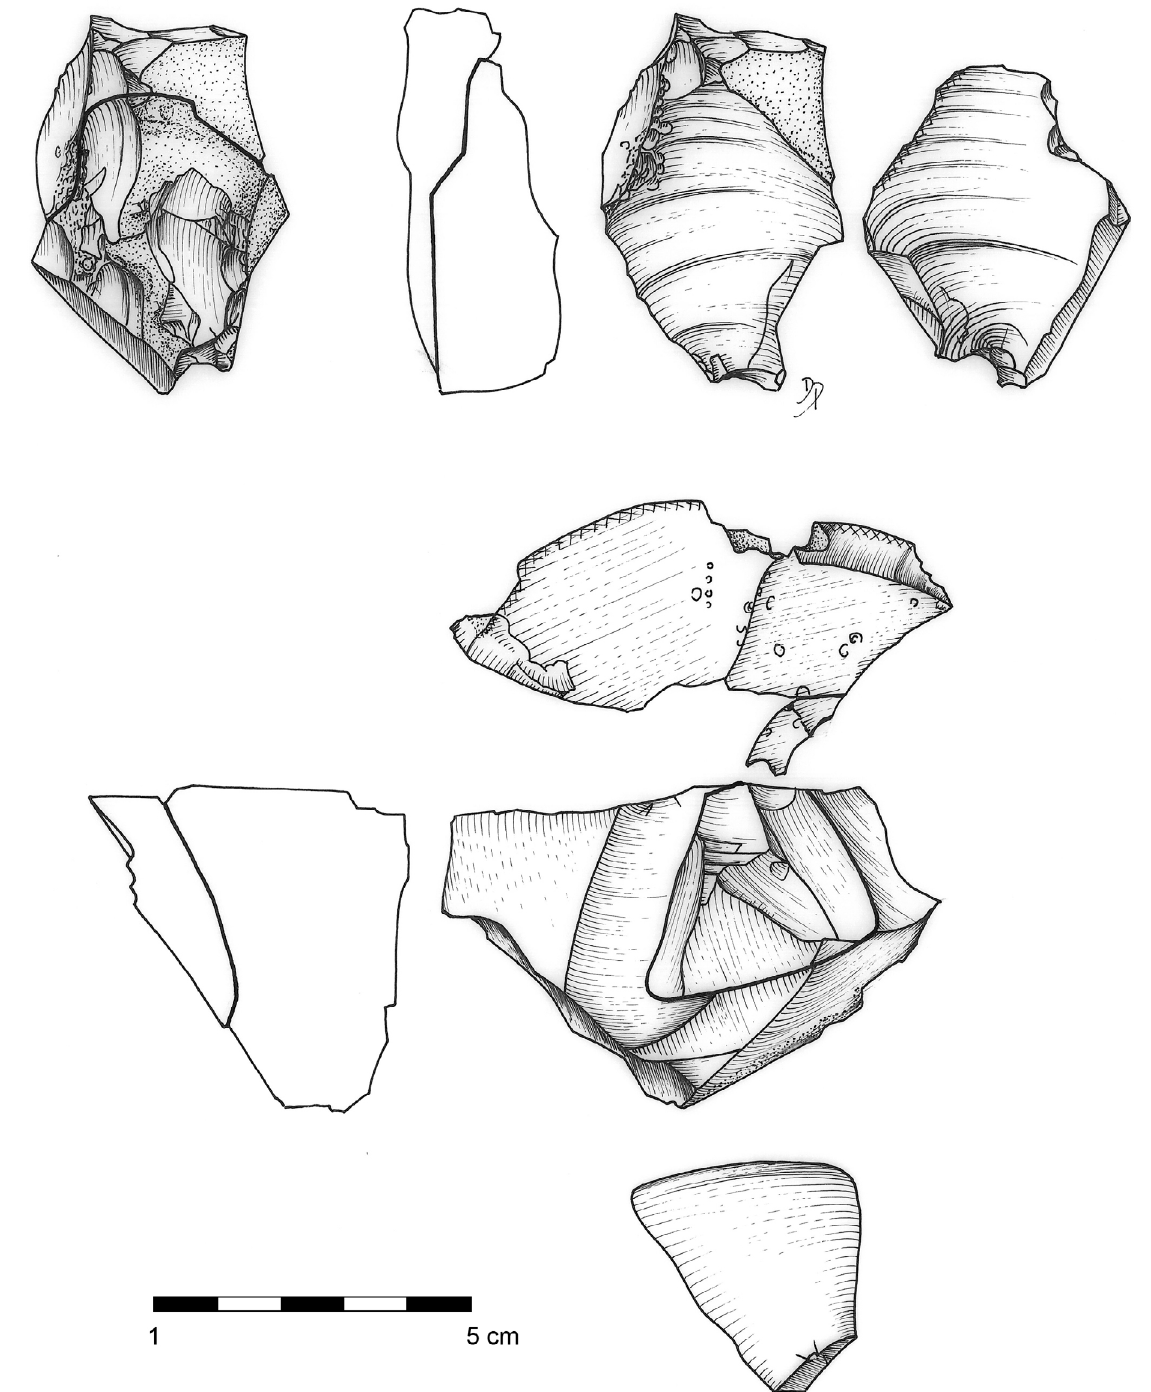
Figure 4. Remontage d’éclats du site de Saint-Pierre-d’Autils « Le Plaquis » (Eure). Dessin de D. Prost. Figure 4. Refitting of flakes from Saint-Pierre-d'Autils site "Le Plaquis" (Eure). Drawing by D.